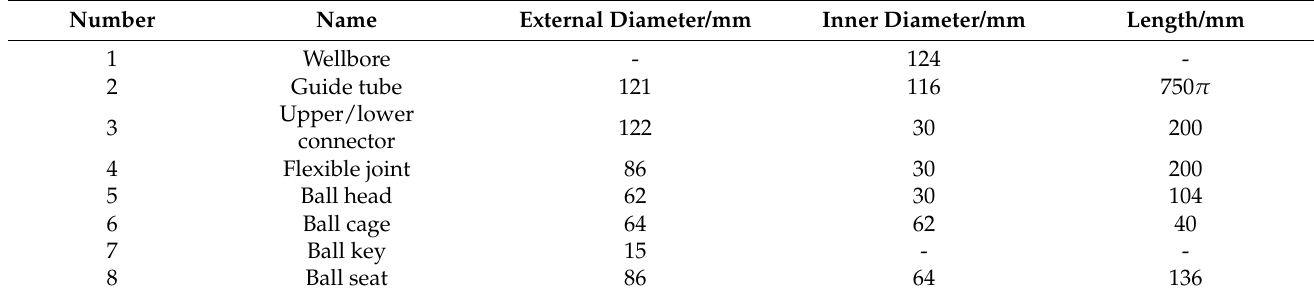
Table 1. Geometric parameters of the model.